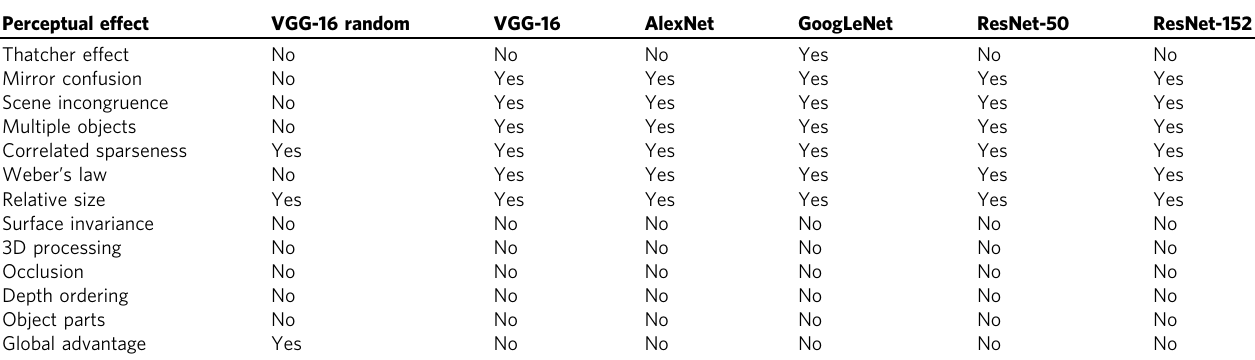
Table 1 Presence/absence of each effect across deep networks